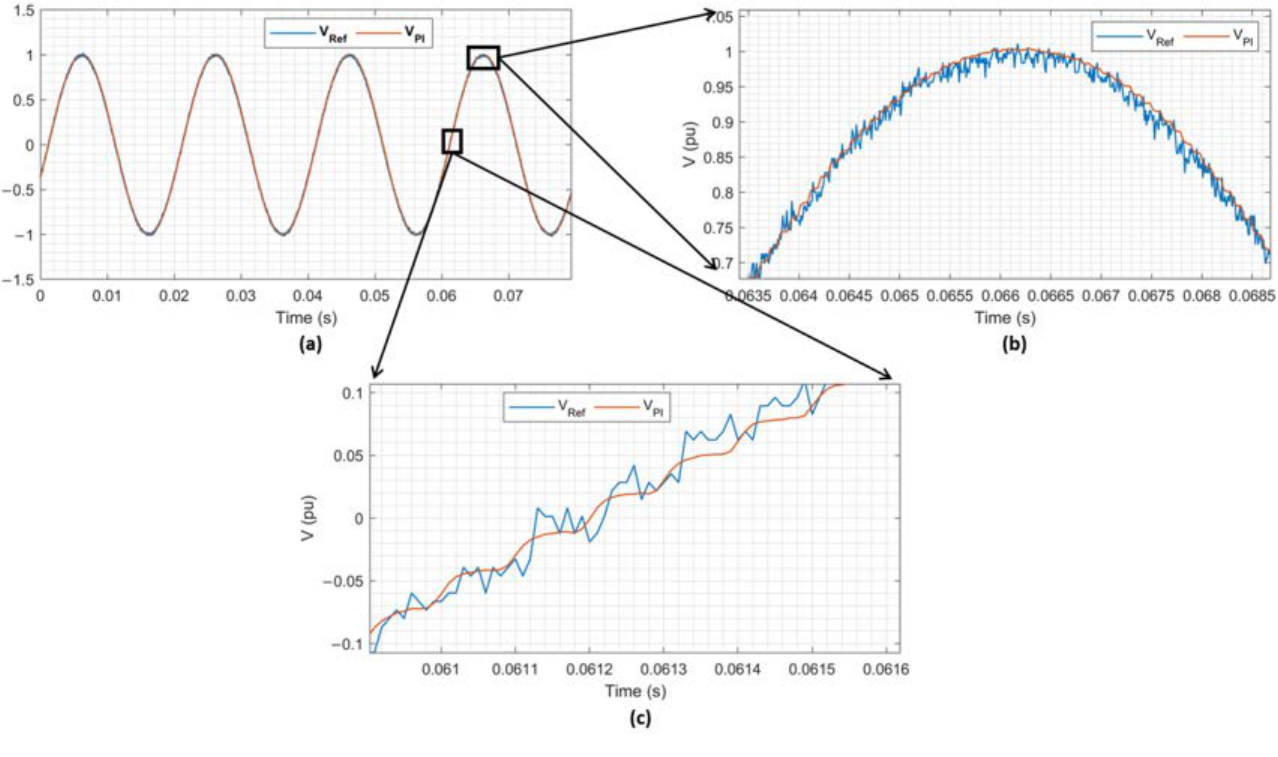
Figure 10. Voltage Comparison. ( a ) Reference and power interface generated voltage waveforms in real-time. ( b ) Zoomed-in version at one of the instants to analyze the inaccuracies between the simulated and real-world interface output voltage. ( c ) Zoomed-in version at the zero-crossing to analyze the time